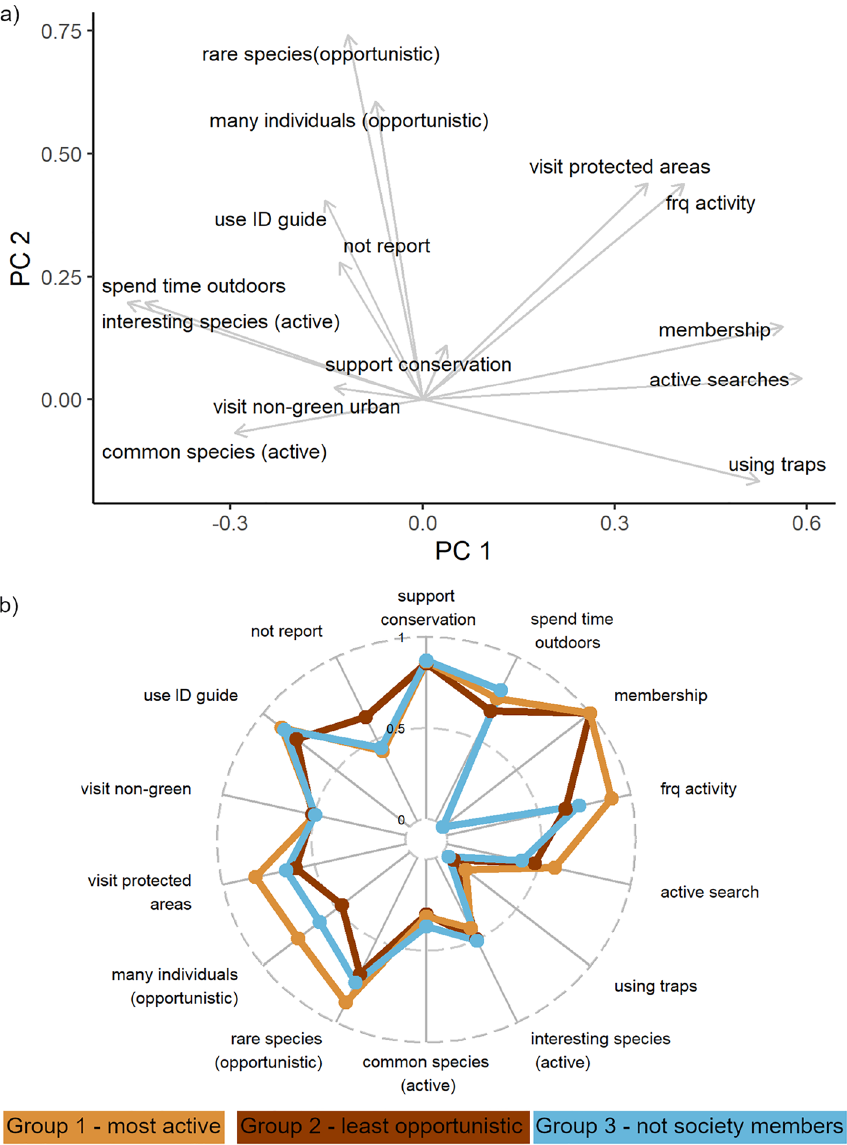
Figure 4. Dimension reduction: ( a ) a PCA analysis of the top items of all question groups (PC axis 1 explained 13% of the variation and PC axis 2 explained 12% of the variation) and ( b ) characteristics of the main respondent groups from a k-means cluster analysis. Points on each axis represent the mean value for people within each group (separated by different colours) scaled between the minimum and maximum values. Table S1 gives a fuller description of all question